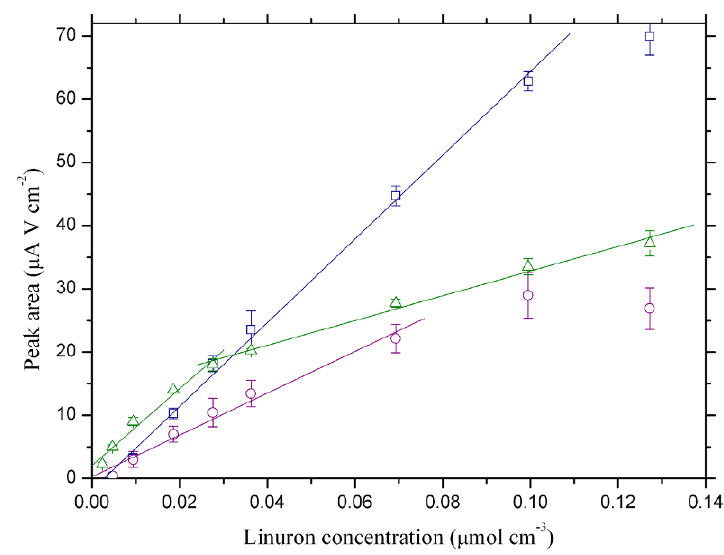
Figure 5. Peak area of linuron oxidation vs. linuron concentration for different working electrodes. Experimental conditions: electrolyte 0.1 mol dm -3 sulphuric acid, voltage step 0.006 V; sweep rate 0.05 V s -1 . Legend: Δ - GC-Metrohm, □ - GCB and ○ - GC electrode. Full line represents linear fit of the experimental